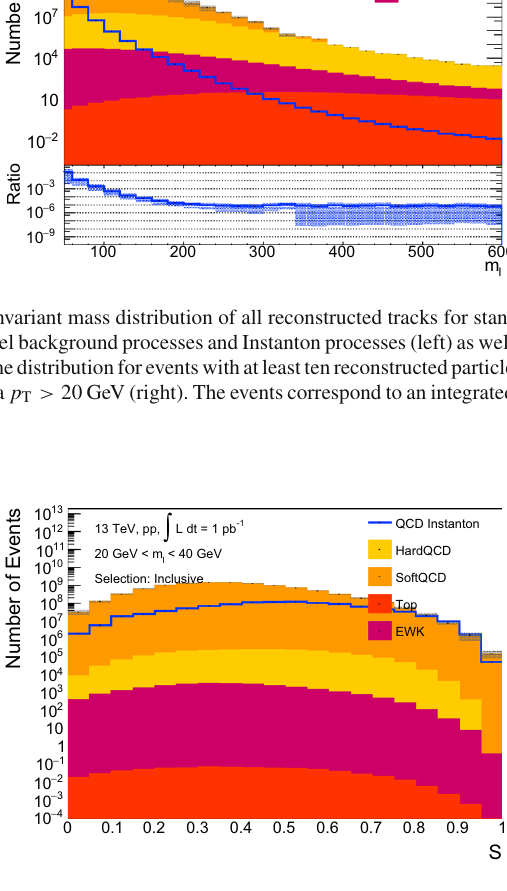
tracks is required to be between 20 and 40 GeV (very low mass regime). The distributions from all SM processes except for the Instanton are stacked. The model uncertainties are indicated as bands